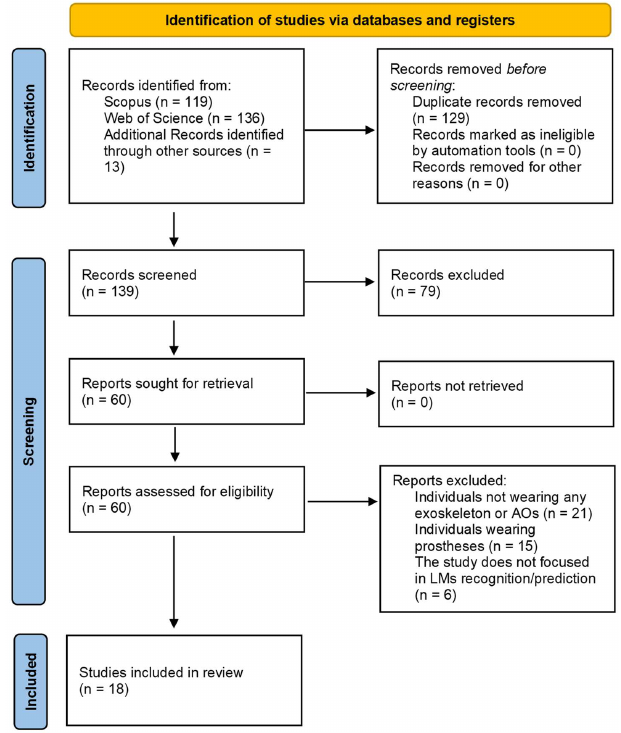
Figure 1. PRISMA flow chart for LM recognition and prediction. Table 1. Quality assessment of the included